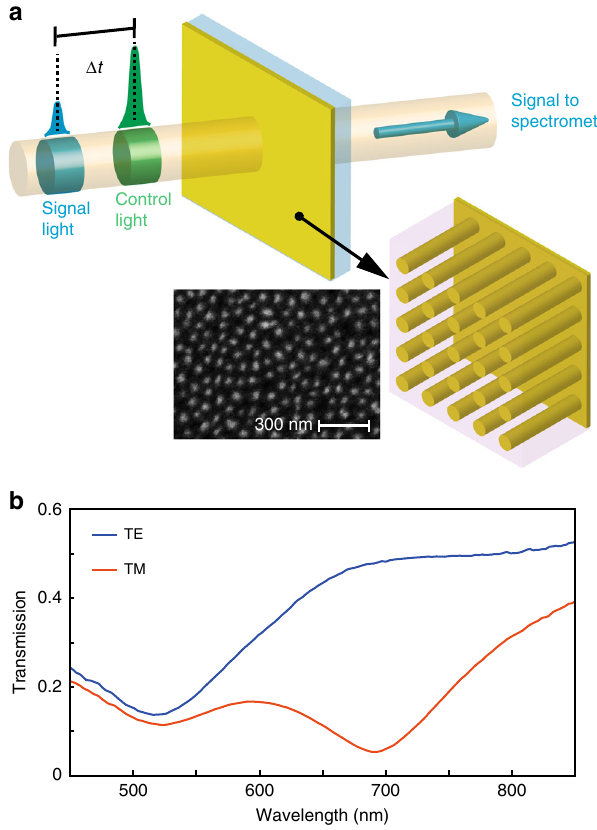
Fig. 1 The nanorod metamaterial and its linear optical properties. a Schematic of the transient transmission measurements and the nanorod- based metamaterial. The control light is TE polarised, while the signal light is TM polarised. Inserts show the schematics and SEM image of the metamaterial. b Transmission spectra of the metamaterial (Au nanorods of approximate dimensions 400 nm length, 70 nm period and 30 nm diameter) for TE and TM polarised light at an angle of incidence of